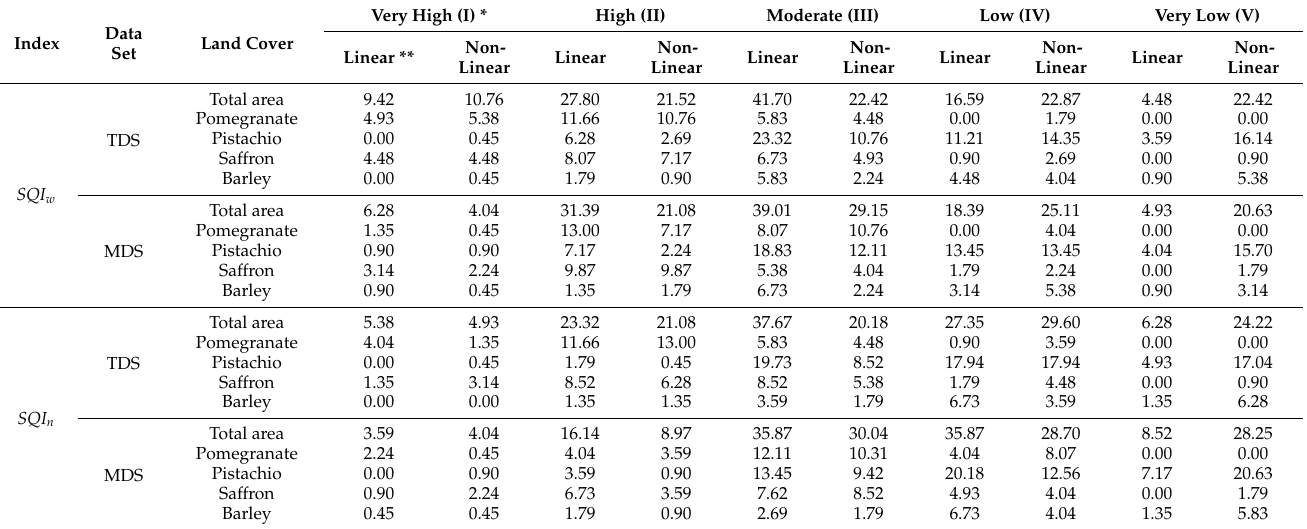
Table 7. Percentage of soil quality grades for different indices, data sets (TDS and MDS), and scoring methods in the studied